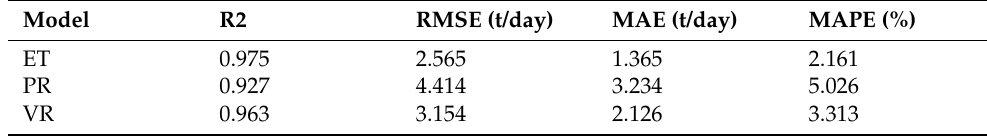
Table 2. Accuracy differences before and after fuel consumption model integration on the test set.